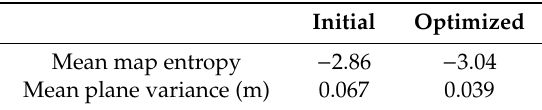
Table 7. The precision evaluation result of the Cartographer